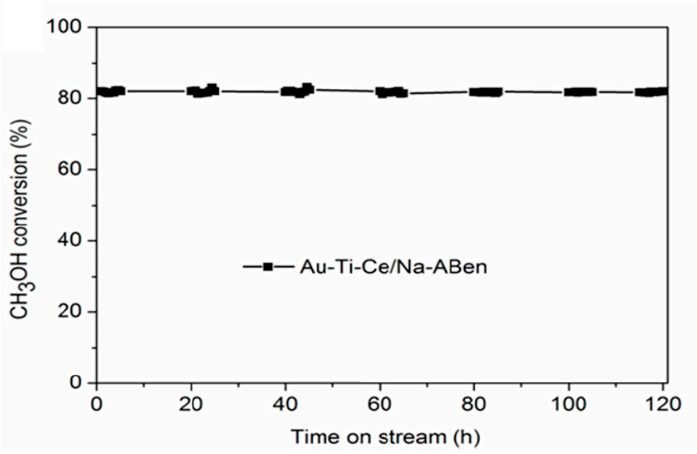
Figure 14. Time-on-stream test. T = 400 °C, CH 3 OH/H 2 O = 1, 0.175 mL ∙ h − 1 [188].